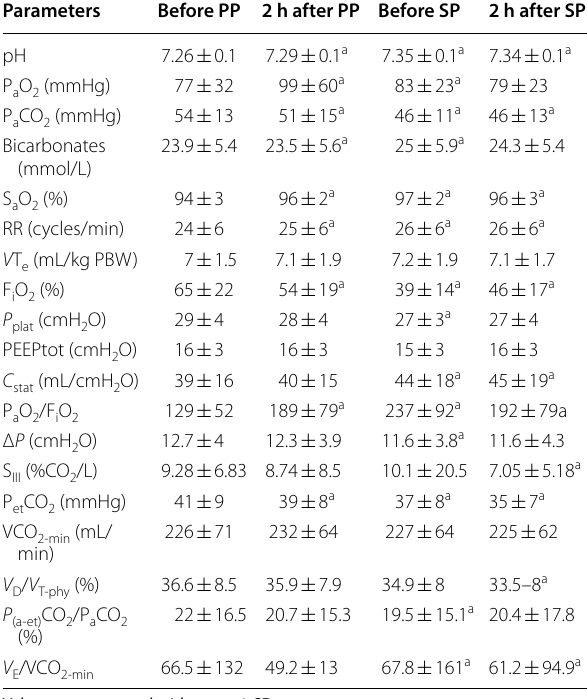
Table 2 Arterial blood gas, lung mechanics and volumetric capnography data during the first PP session